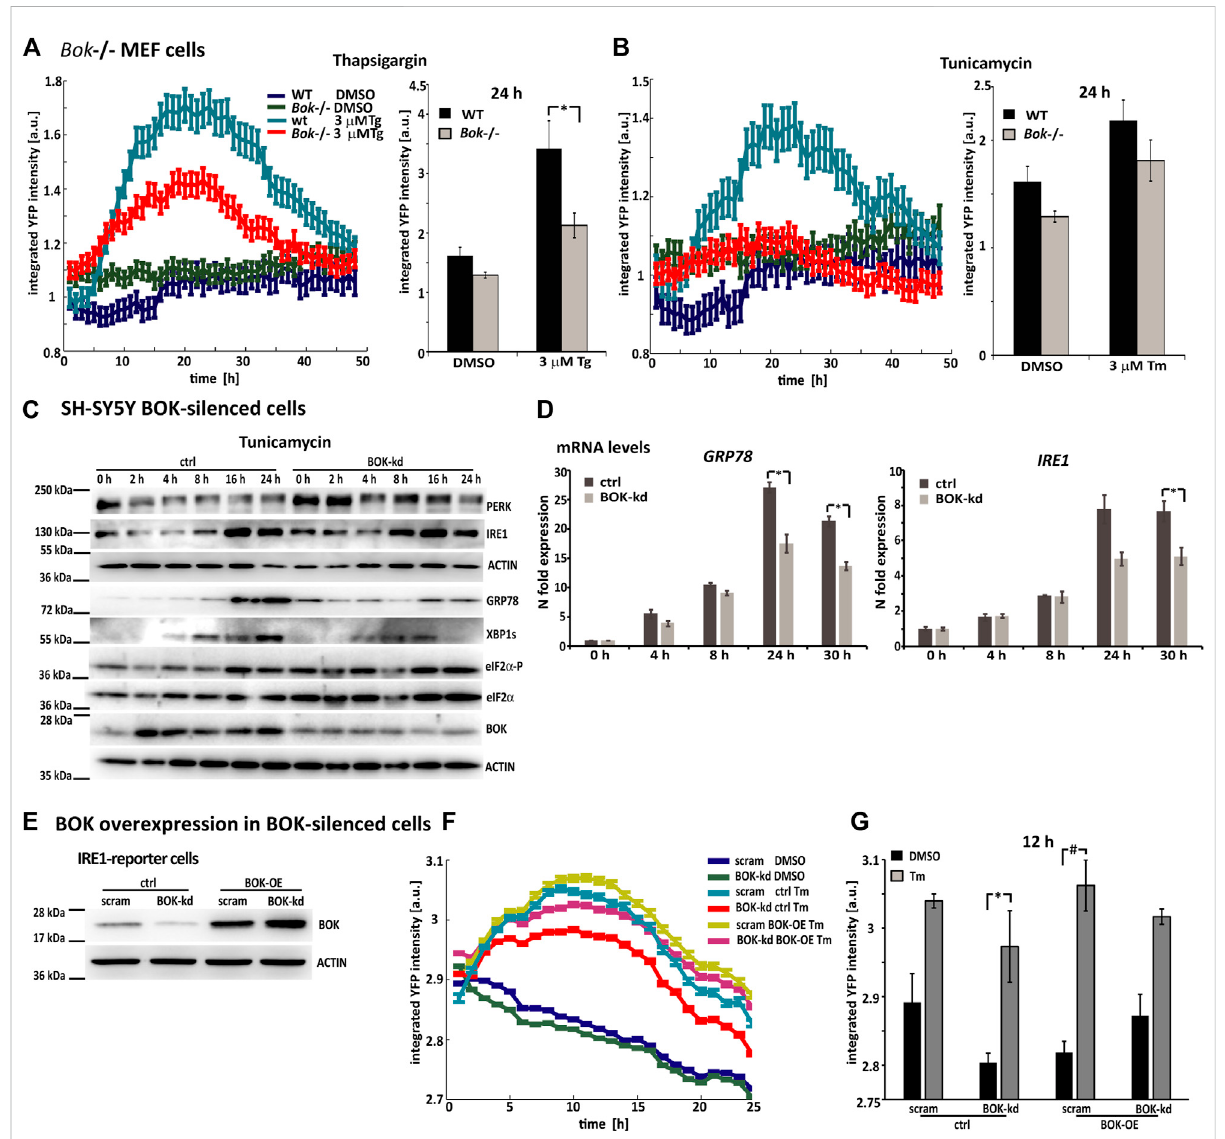
FIGURE 3 Reduced ER stress signaling is a general response in BOK-de fi cient cells, which can be rescued through overexpression of BOK. (A) Mouse embryonic fi broblasts from WT or Bok − / − knock-out mice were transduced with viral particles containing the PERK-reporter construct; 72 h after transductions, cells were stained with Hoechst and PI and treated with 3 μ M Tg and (B) 3 μ M Tm or 0.1% DMSO. Images were taken at 1-h intervals starting immediately after treatment for 48 h using high-content time-lapse live-cell imaging. The mean YFP intensity over time of the PERK- reporter in the Bok − / − and WT cells was plotted. Error bars indicate SEM of at least n = 2 wells. Bar graphs show mean YFP intensity 24 h after treatmentwith3 μ MTgor3 μ MTmor0.1%DMSOcontrol.ErrorbarsindicateSEMofatleast n =7wellsofthreeindependentexperiments . Student ’ s t-testswereperformedcomparing Bok − / − andWT.*indicates p < 0.01. (C) SH-SY5YcellsstablyexpressingshRNAagainst BOK orcontrolvectorwere treated with 3 μ M Tm and harvested at the times indicated. Expression of UPR proteins was analyzed by Western blotting using antibodies against PERK, IRE1, KDEL, spliced XBP1s, eIF2 α -P, eIF2 α , and BOK. Actin served as a loading control. The experiment was repeated with similar results. (D) Real-time qPCR analysis of GRP78 - and IRE1 -mRNA levels in SH-SY5Y BOK-silenced- and control cells treated with 3 μ M Tm. Results were normalized to β -actin levels and expressed relative to 0 h control- or BOK-kd cells, respectively (mean of n = 3 wells, error bars indicate SEM, and Student ’ s t-tests were performed comparing control and BOK-kd; * indicates p < 0.05). (E) IRE1-reporter cells stably expressing shRNA against BOK or control vector were transfected with BOK overexpression construct hBok (CDS)-pcDNA or empty pcDNA3.1 plasmid. Expression of BOK was analyzed by Western blotting using antibodies against BOK. Actin served as a loading control. The experiment was repeated with similar results. (F) After24 hoftransfection,cellswerestainedwithHoechstandPIandtreatedwith3 μ MTmor0.1%DMSO.Imagesweretakenat1-hintervalsstarting immediately after treatment for 25 h using high-content time-lapse live-cell imaging. The mean YFP intensity over time of the IRE1-reporter in the BOK-kdandcontrolcellswasplotted.ErrorbarsindicateSEMofatleast n =3wells. (G) BargraphsshowmeanYFPintensity12 haftertreatmentwith 3 μ M Tm or 0.1% DMSO control. Error bars indicate SEM of atleast n = 3 wells . Student ’ st-testswere performed comparing Tm- and DMSO-treated cells. * indicates p < 0.05; # indicates p =